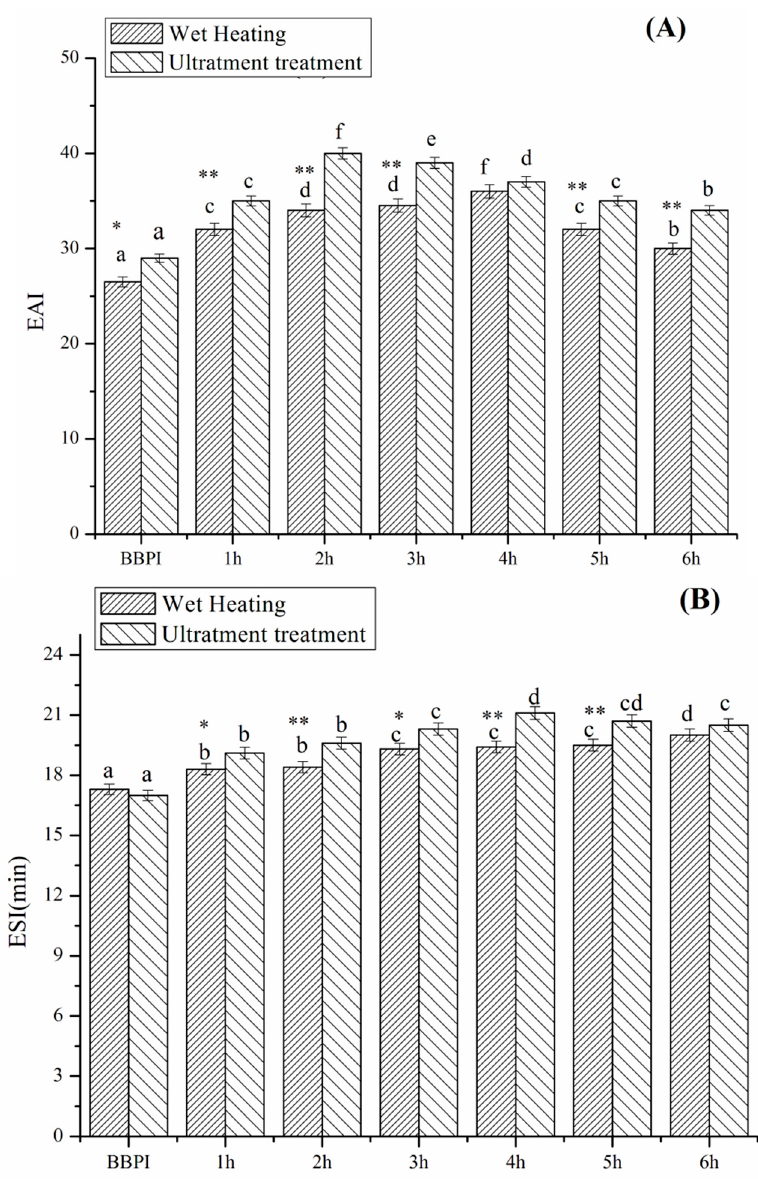
Figure 5. Emulsification activity ( A ) and emulsification stability ( B ) of BBPI by wet heating and ultrasound treatment Maillard reaction obtained after 1–6 h, respectively. Means with dissimilar lower-case letters indicate significant differences ( P < 0.05), ** means in the same time P < 0.01, * means in the same time P < 0.05.